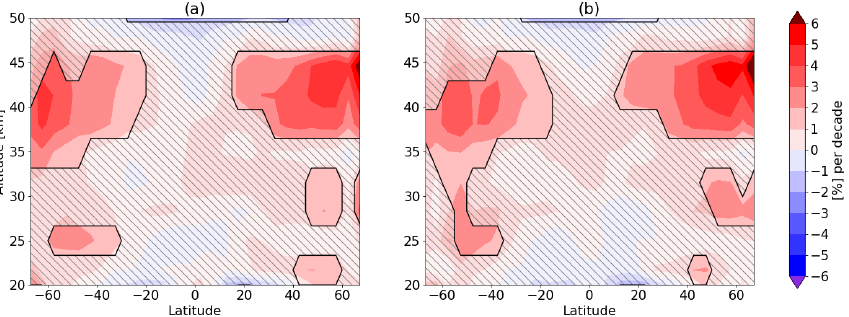
Figure 6. Zonal mean linear long-term ozone changes over the 2003–2018 period derived from the SCIAMACHY/OMPS-LP merged data sets: panel (a) shows the results using anomalies, and panel (b) shows the results using the “plain-debiased” data set. Dashed areas indicate non-significant